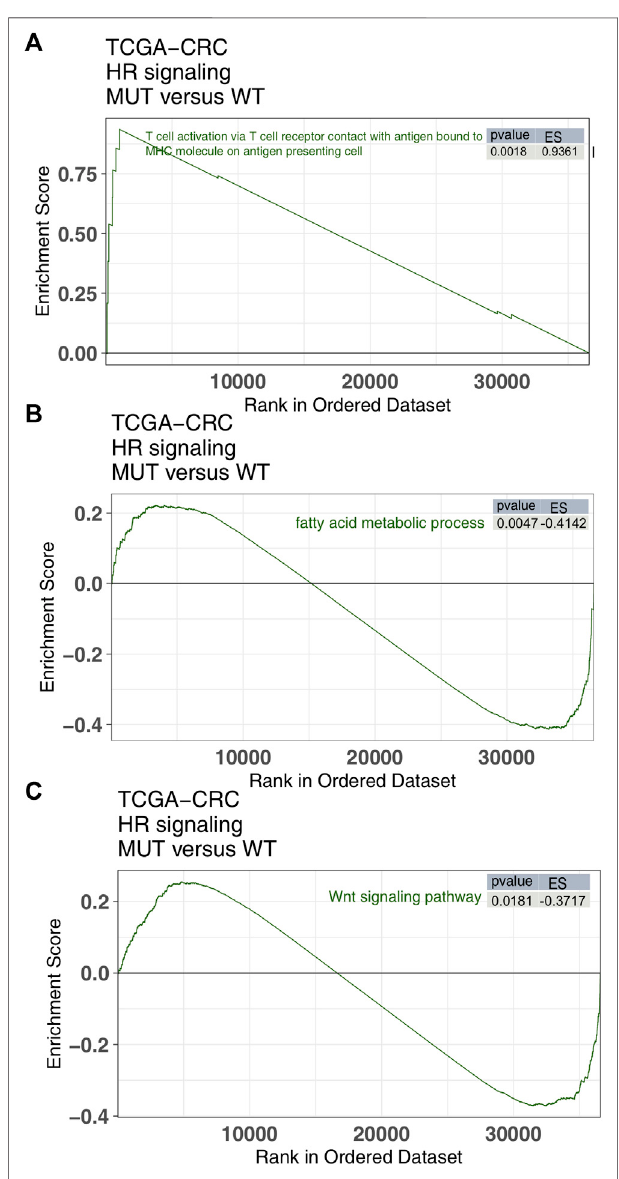
FIGURE 5 | The GSEA results. A comparison of the enrichment scores of immune-related (A) , tumor metabolism (B) and tumor metastasis/growth (C) found in the HR-MUT and HR-WT groups based on the GSEA algorithm.